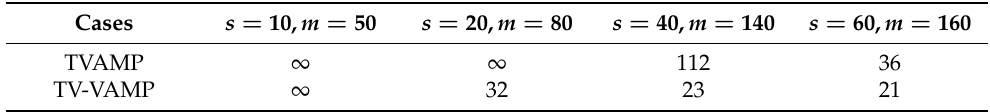
Table 1. Average number of iterations to achieve NMSE = − 60 dB for zero-mean Gaussian distribution measurements